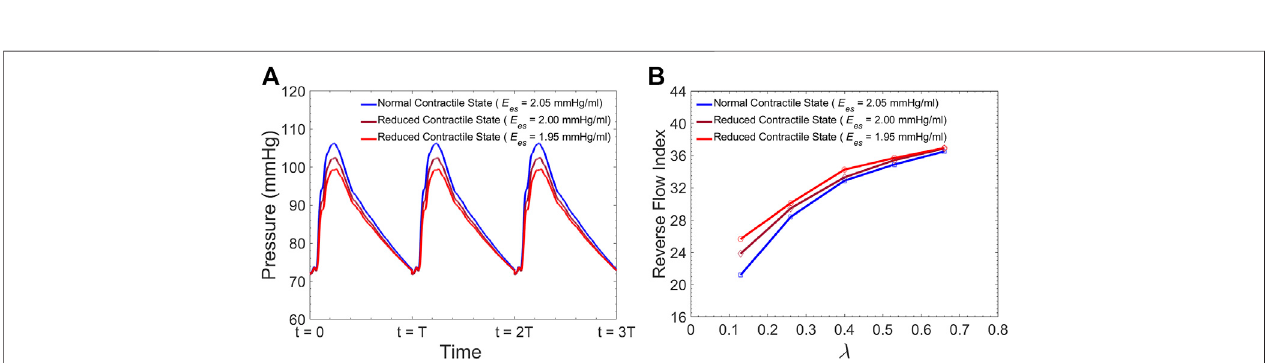
FIGURE11| Average ReverseFlow Index inside theFLper cardiac cycle versus (A) the λ (endograft-septum length ratio) at differentHRsand versus (B) the HRat different λ .